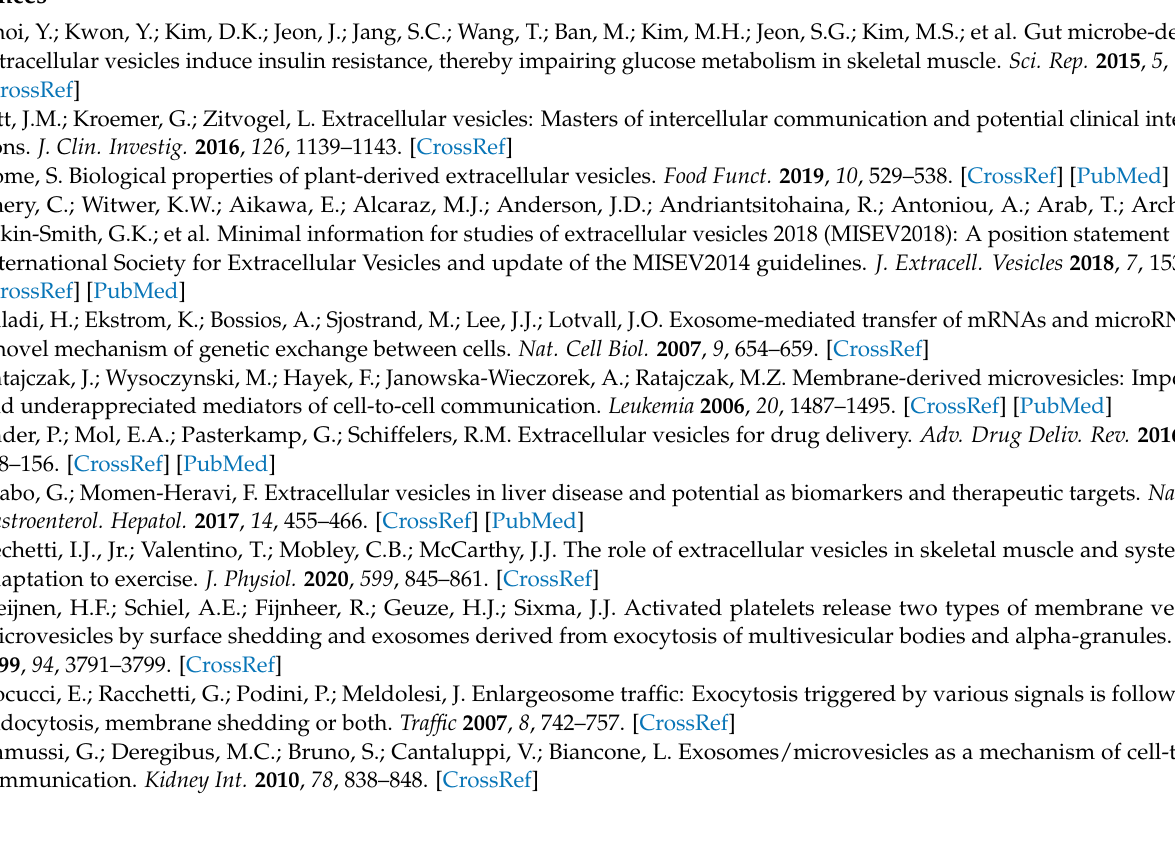
cells; Figure S2: Sphingomyelin (SM) composition of C2C12 myotube cells; Figure S3: Ceramide (Cer) composition of C2C12 myotube